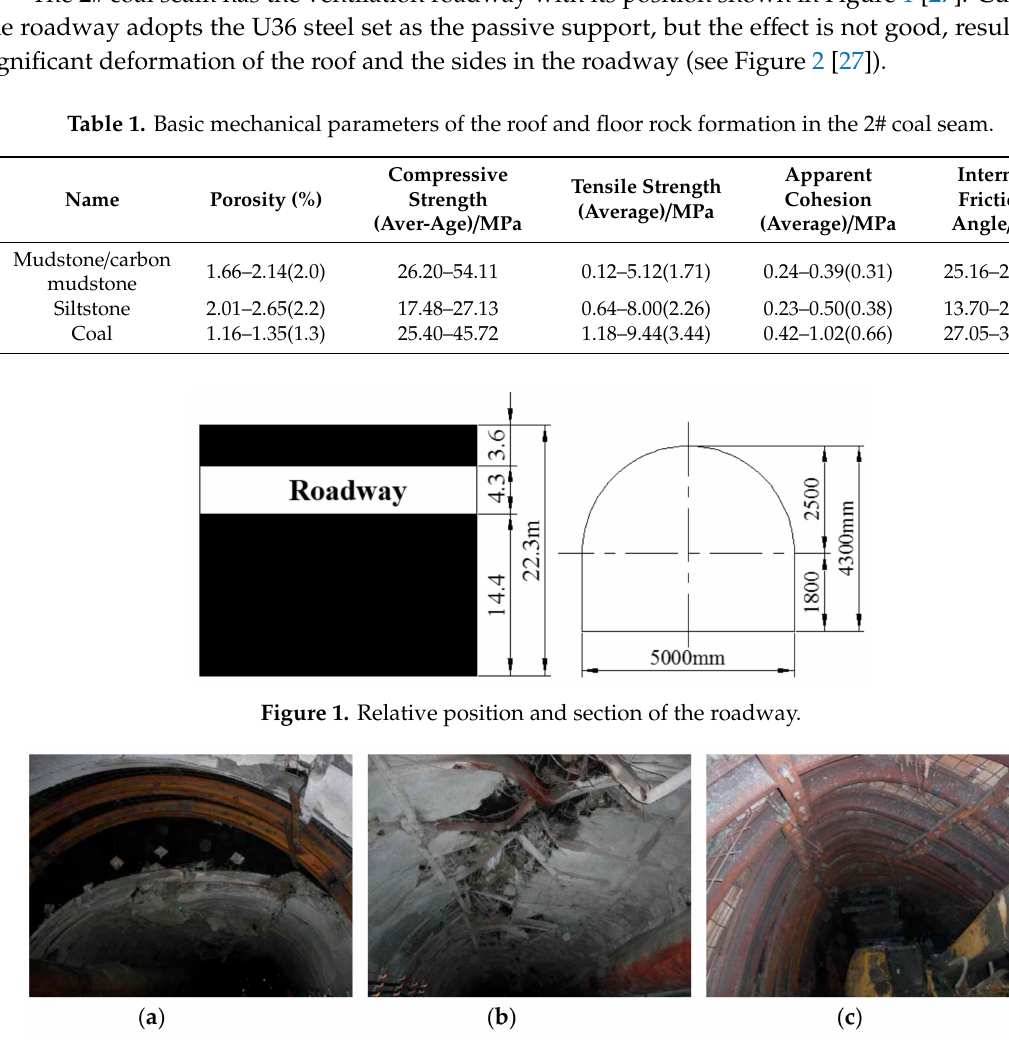
Figure 2. Destroyed roadway surrounding